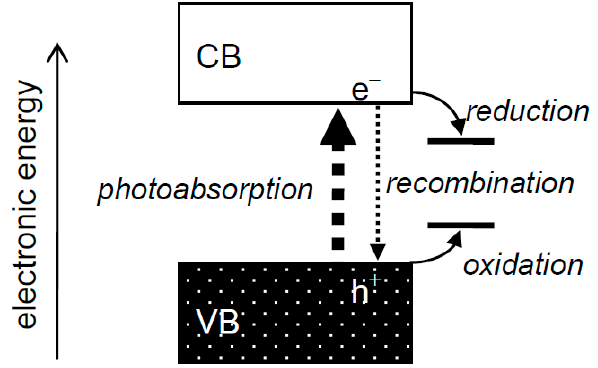
Figure 2. Commonly used interpretation of heterogeneous photocatalysis in recent years [1]. CB, conduction band; VB, valence band.